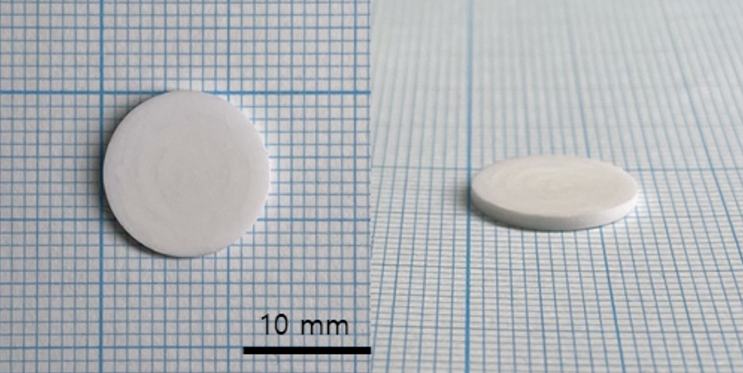
Figure 20. Sintered specimen of micro square pa tt ern.